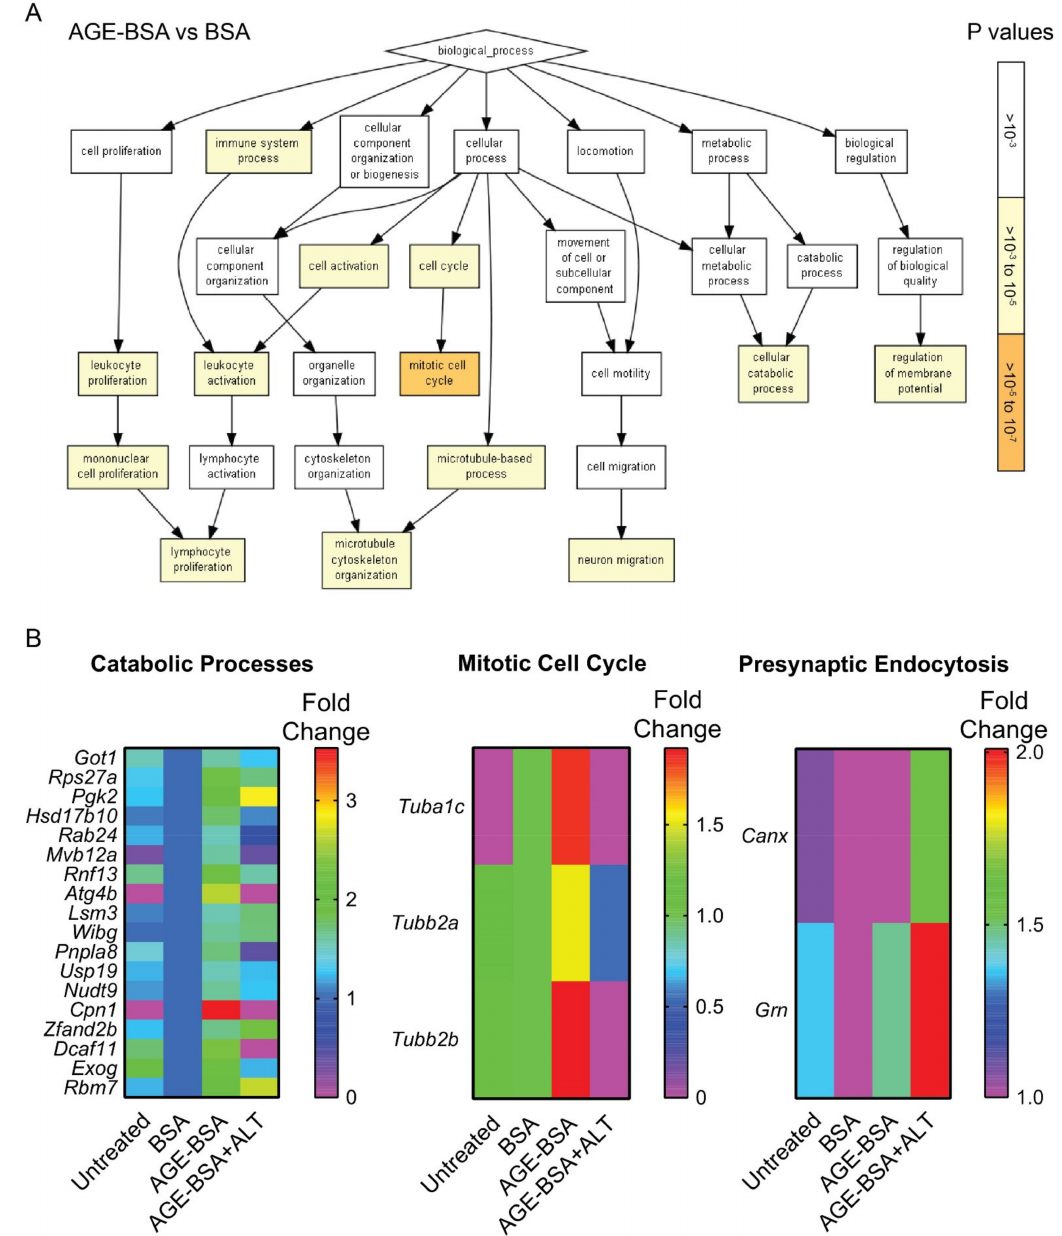
Figure 5. Gene Ontology enrichment analysis of biological processes in peptides isolated from MIN6N8 NOD derived beta cells. NOD ShiLt derived MIN6N8 beta cells were treated overnight with unmodified (BSA; 100 µ g/mL), AGE- modified BSA (AGE-BSA; 100 µ g/mL) without or with alagebrium chloride (AGE-BSA+ALT; 40 µ M). The whole-cell proteome was performed on the cell lysate flowthrough that did not bind to MHC Class 1a antibodies. The effluents were trypsinised, peptides labelled with TMT using different isotypes and identified using LC-MS/MS. Workflow for proteomics is represented in Figure 4B. ( A ) Pathway analysis of peptides enriched following AGE-BSA vs. BSA treated MIN6N8 cells. p values (right; 10 − 3 to 10 − 7 ) shown in white-orange scale. ( B ) Heatmaps of proteins associated with three major enriched Gene Ontology pathways after AGE-BSA and AGE-BSA+ALT vs. control (BSA) MIN6N8 treated cells. Scale shows fold